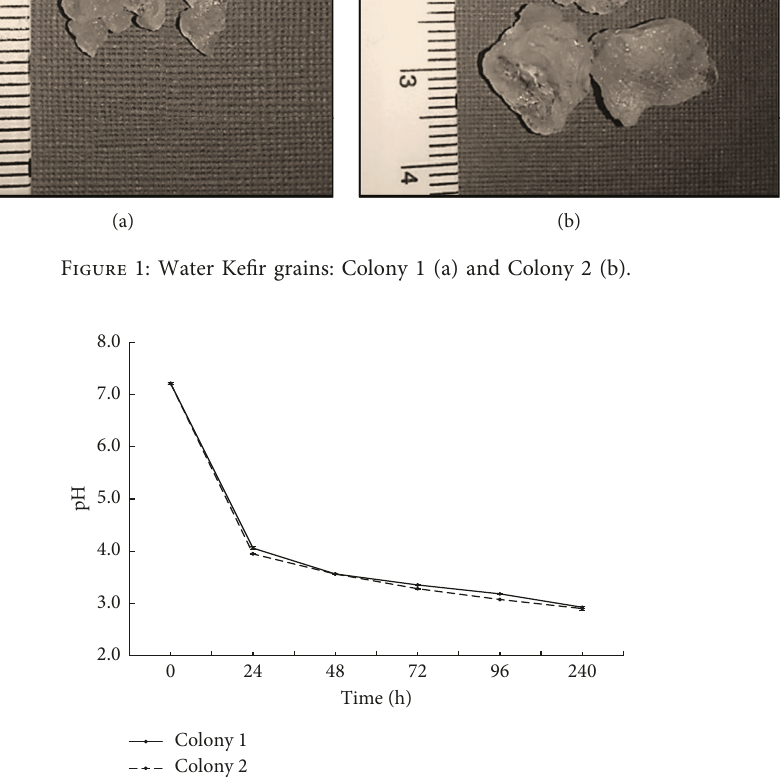
7.0, 1:10 Water Kefir/metal (cid:30)